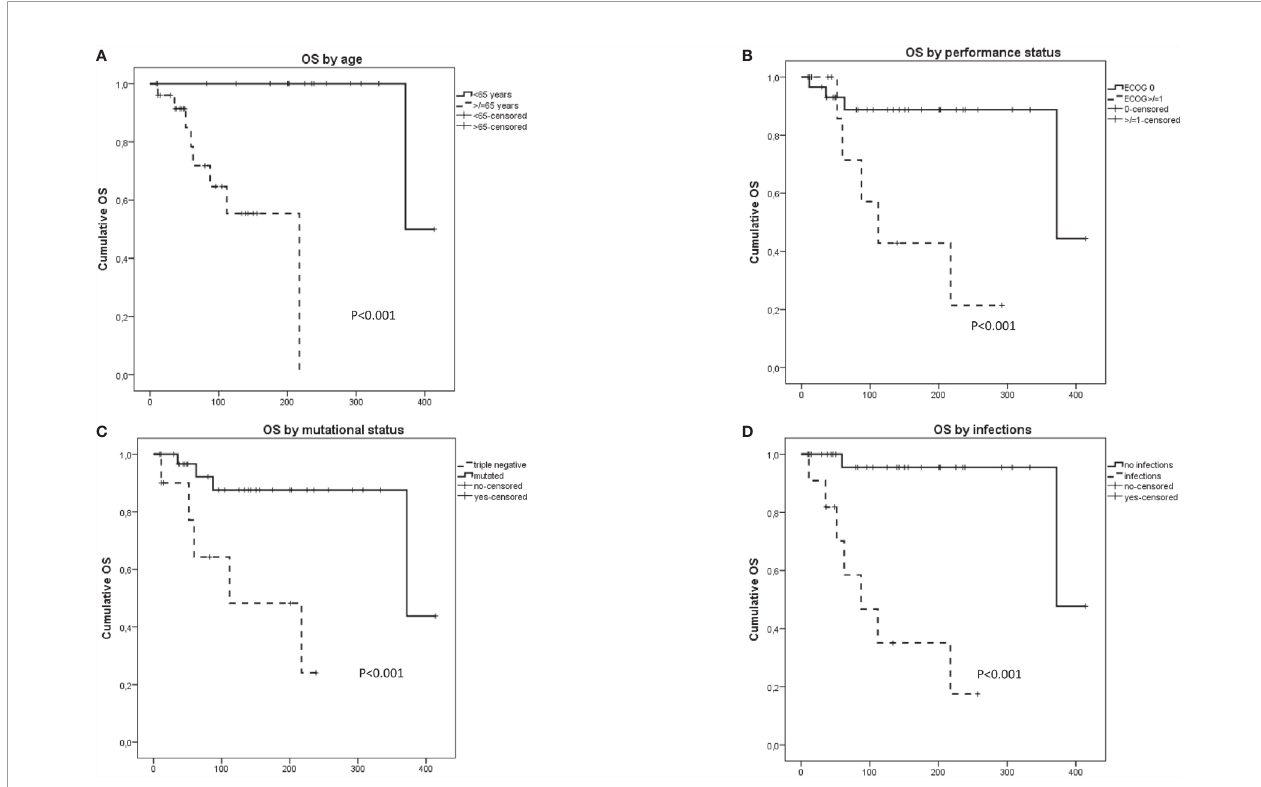
FIGURE 1 | Overall survival in patients with concomitant myeloid and lymphoid neoplasms according to (A) age, (B) performance status, (C) presence of driver mutation, and (D) infectious complications.